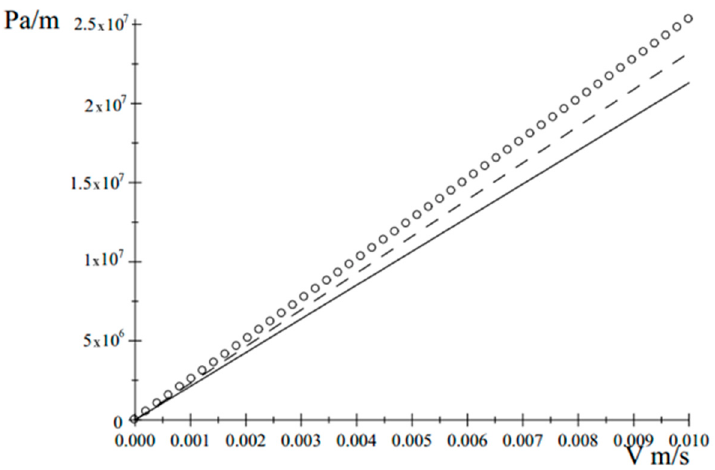
Figure 5. Emulsion composition effect with porosity ε = 0.4, particle diameter d p = 0.001 m, and dispersed phase volume fraction ϕ = 0.01 (solid line), 0.1 (dashed line), and 0.2 (dotted line).